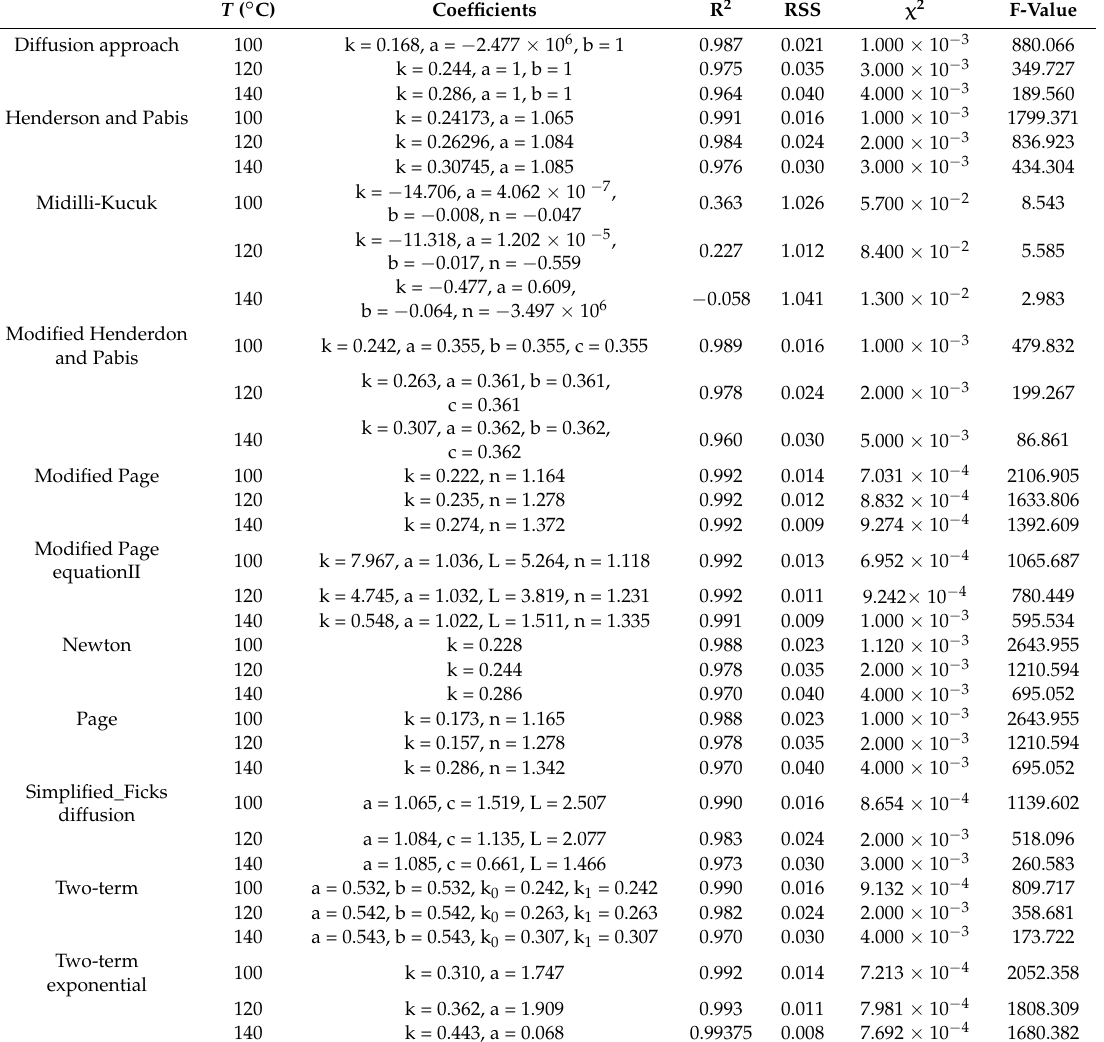
Table 3. Evaluated results of mathematical thin-layer drying models at different